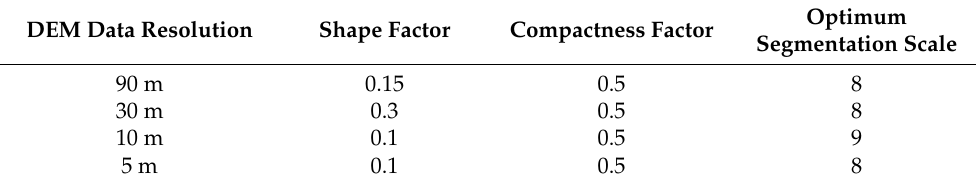
Table 1. Parameters used in object-oriented multiresolution segmentation.